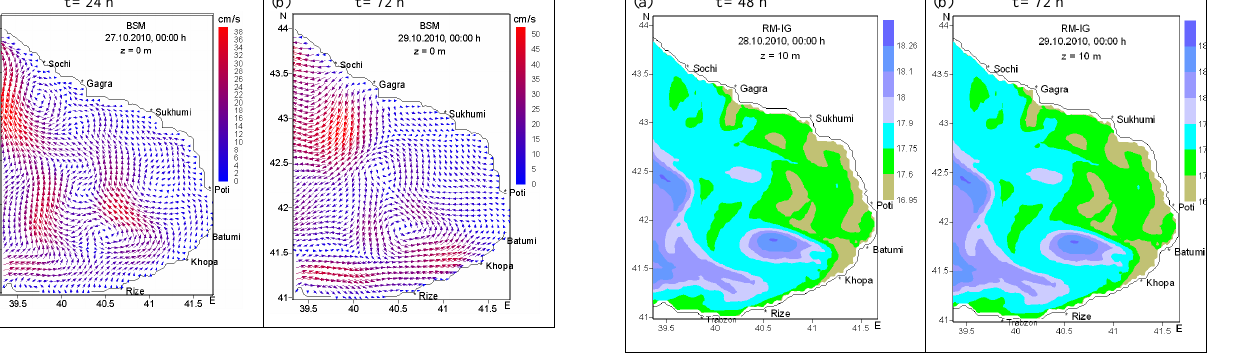
Fig. 17. The salinity fields (psu) on depth of 10 m predicted by RM-IG at 48 h (a) and 72 h (b) (forecasting period is 26.10.2010, 00:00 h – 29.10.2010, 00:00 h ).